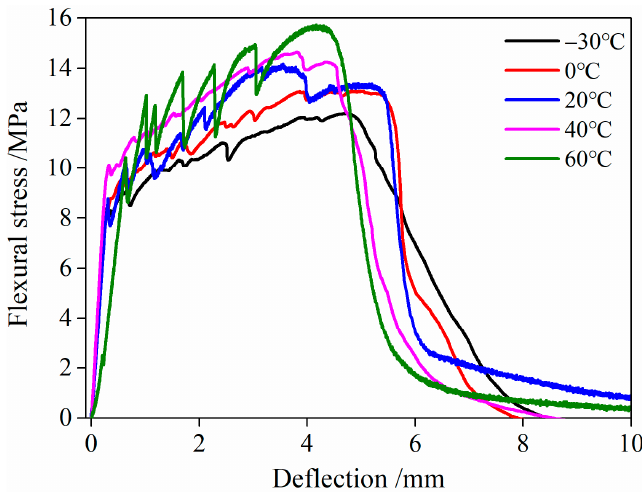
Figure 16. Flexural stress and deflection relationship curve of HDC. Table 8. Feature parameters of flexural property for